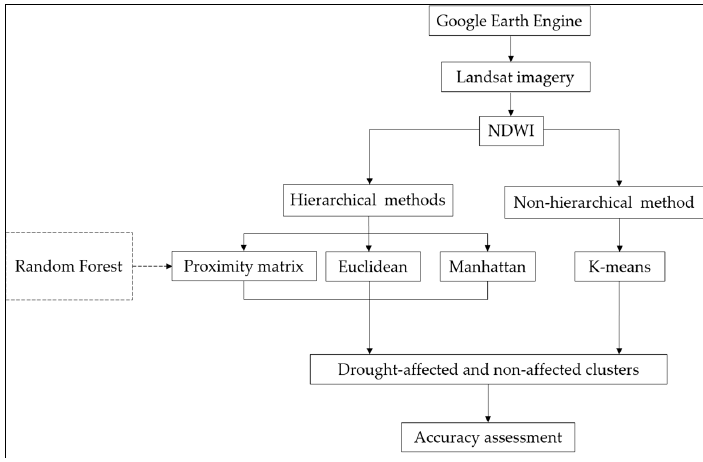
Figure 3. Flow diagram of drought clustering analysis.